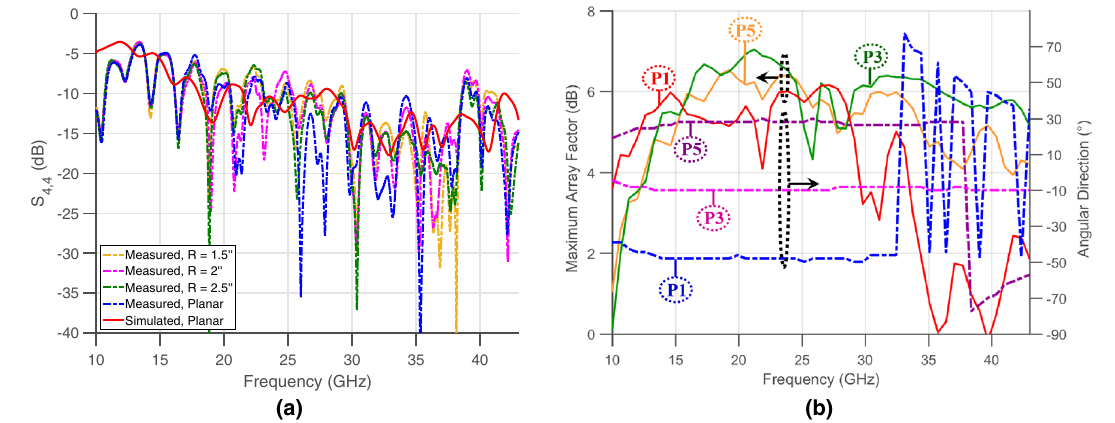
Figure 2. ( a ) Plot of the simulated and measured reflection coefficients at beam port 4 under planar and bent conditions and ( b ) Plots of the maximum array factors and angular directions of beam ports P1, P3 and P5 with respect to